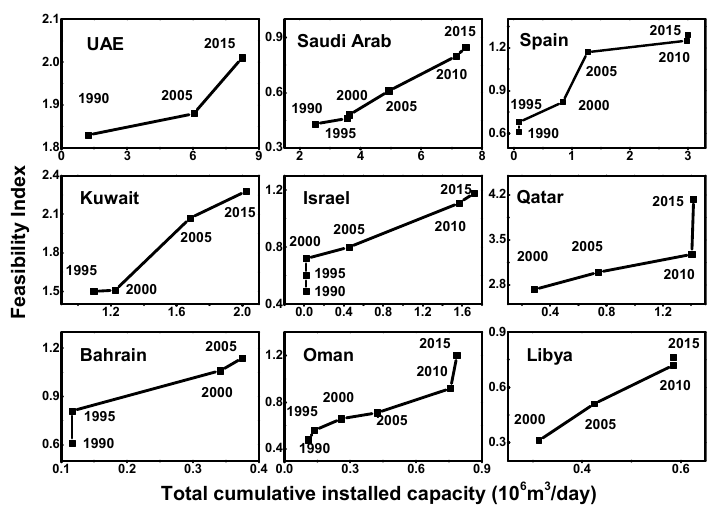
Figure 4. Plot of the total cumulative installed capacity (TIC) against the feasibility index ( F i ) in major SWRO countries. The value for each point shows the specific year of the data.